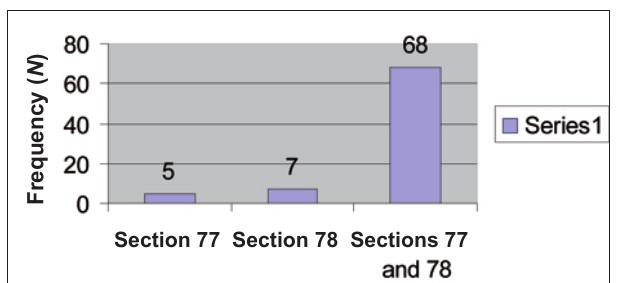
Fig. 4. Referrals in terms of Sections 77 and/or